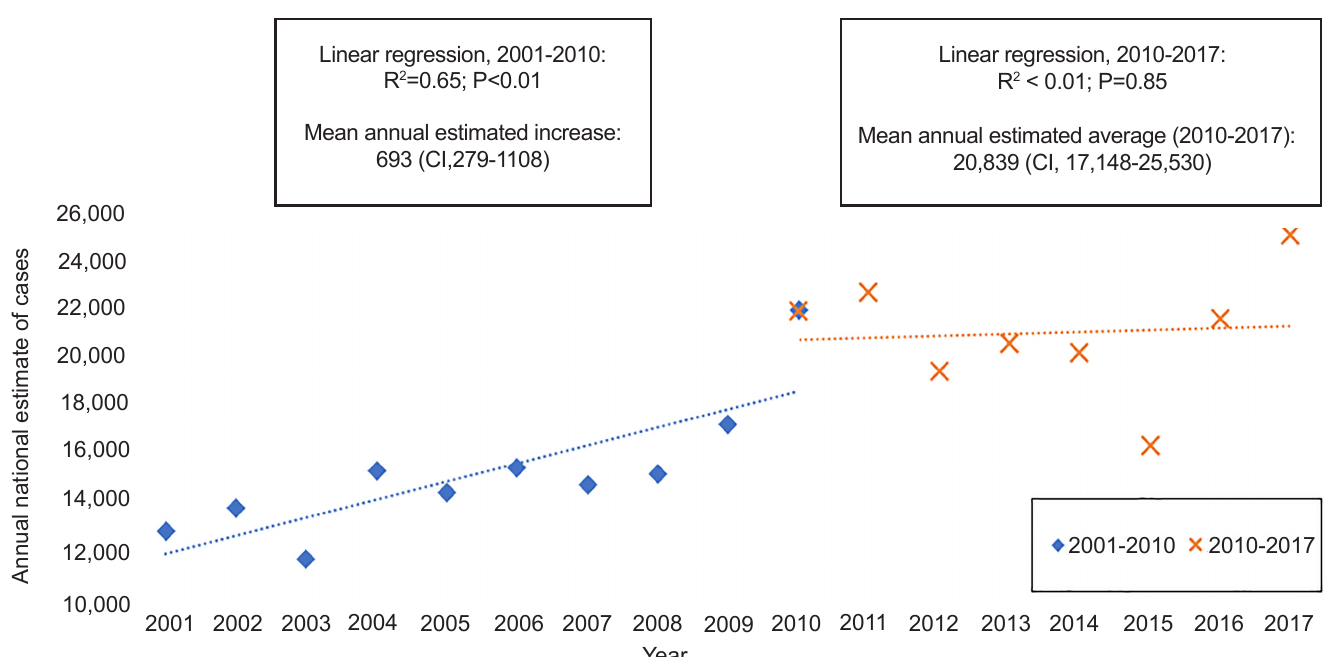
Figure 1. Weighted national estimates of pediatric patients presenting to U.S. emergency departments (EDs) with subluxations of the radial head, 2001-2017. CI ; confidence interval. This figure overlays two linear regression models for the annual national estimate of radial head subluxations presenting to U.S. EDs between 2001 and 2017. The first linear regression model (blue, dotted line) uses annual national estimates (blue, filled diamonds) from 2001 to 2010 as inputs. The second linear regression model (orange, dotted line) uses annual national estimates (orange cross marks) from 2010 to 2017 as inputs. Results from the linear regression models are shown in the text boxes directly above each model.